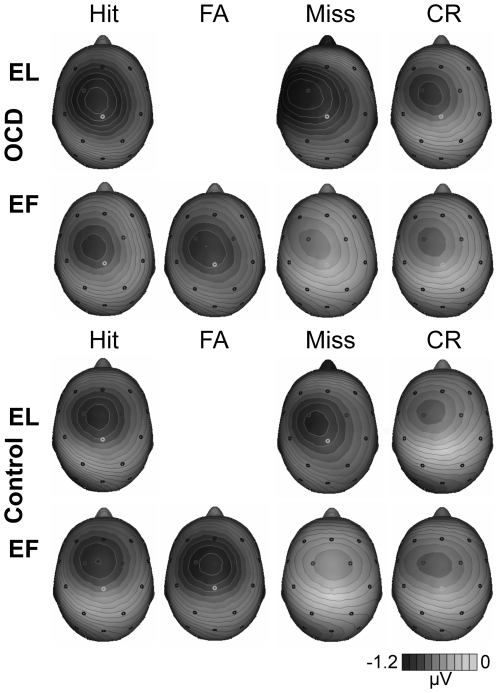
Topographical distributions of the brain potentials.Spline-interpolated isovoltage maps at 60 ms reveal a fronto-central distribution of the brain potentials. Darkest color is most negative.